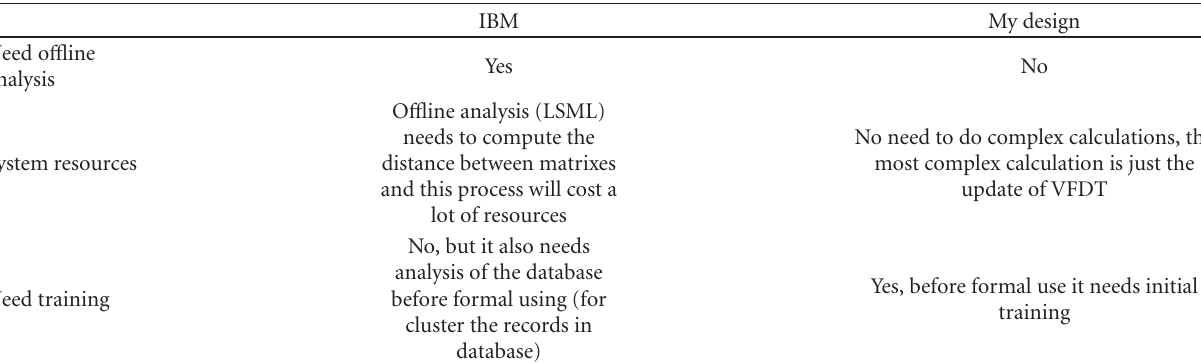
Table 4: Comparison between IBM’s system and our